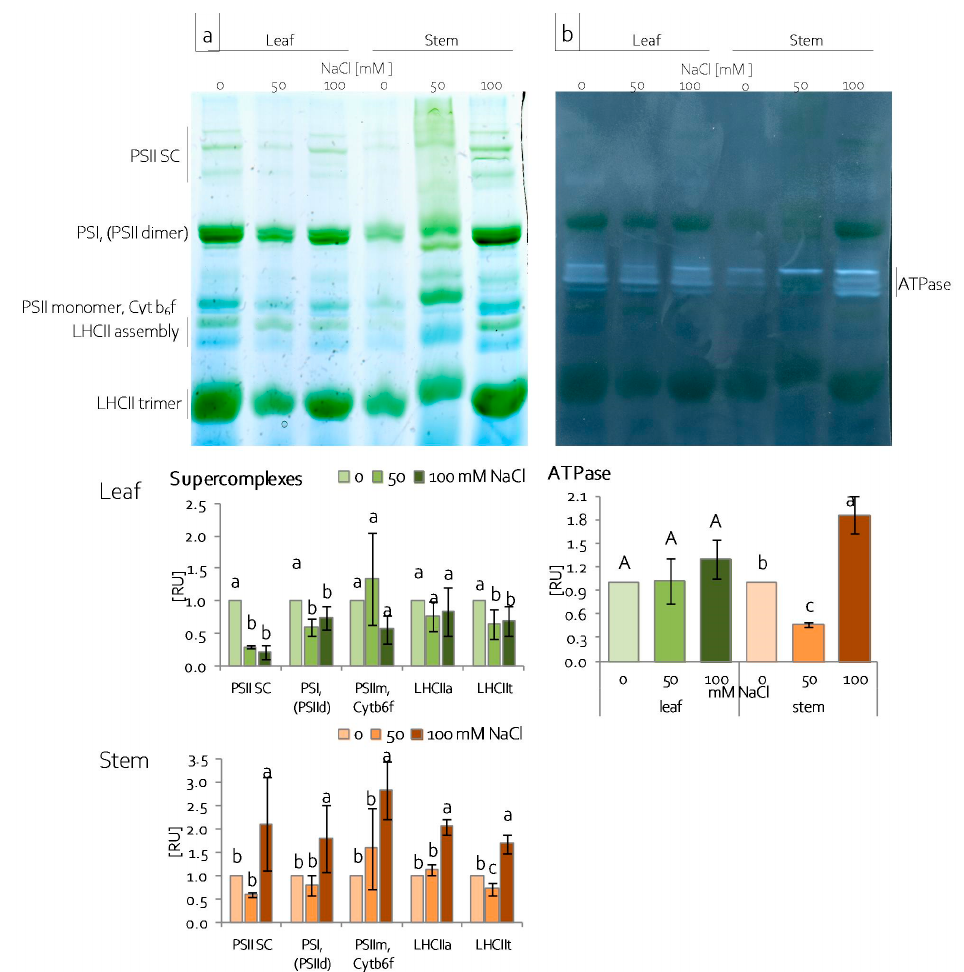
Figure 7. Protein complex and supercomplex content ( a ) and ATPase activity ( b ) in leaf and stem chloroplasts under salinity; PSII—photosystem II, SC—supercomplex, PSIId—PSII dimer, PSI—photosystem I, PSIIm—PSII monomer, Cytb6f — cytochrome b6f , LHCIIa—LHCII assembly, LHCIIt—LHCII trimer; content of proteins expressed as relative units [RU]; different letters—statistically significant differences within each organ (leaf-uppercase, stem-lowercase) at p ≤ 0.05; ( n = 3).